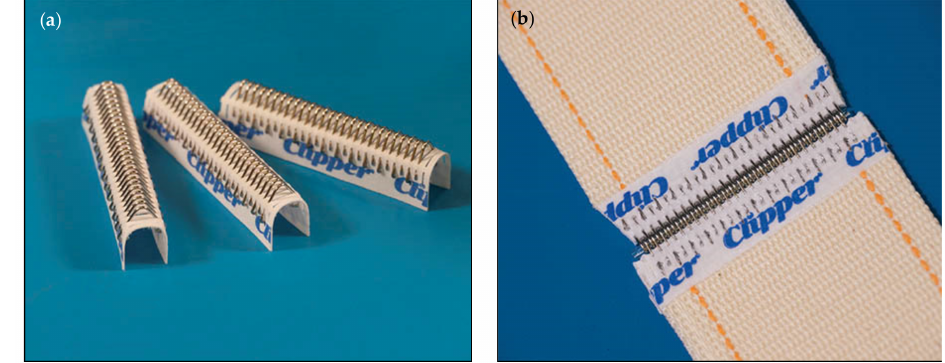
Figure 16. Laundry patch hooks fastening: ( a ) single fastener, ( b ) after mounting [25].